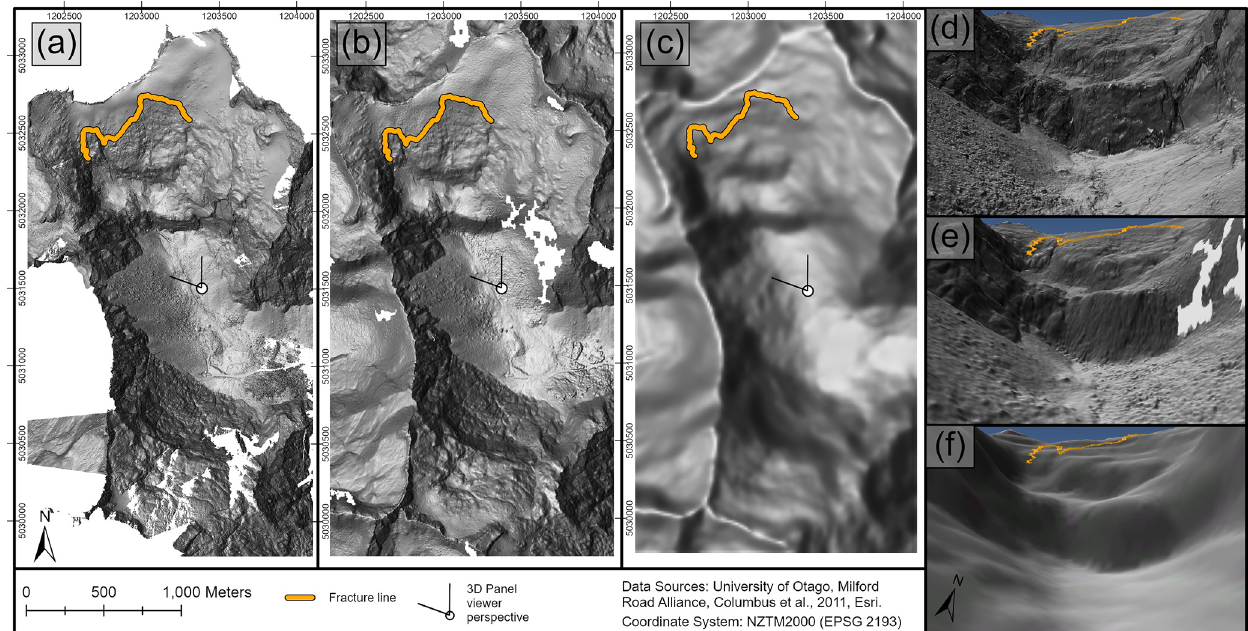
Figure 4. Full-resolution DSMs for TLS surface at 0.5m in panel (a) , SPM surface at 2m in panel (b) and NZSoSDEM surface at 15m in panel (c) . The 3D views focus on the lower cliff face and runout zone of McPherson path, corresponding with TLS 0.5m surface in panel (d) , SPM 2m surface in panel (e) and NZSoSDEM 15m surface in panel (f) . The fracture line from the avalanche event is denoted with an orange